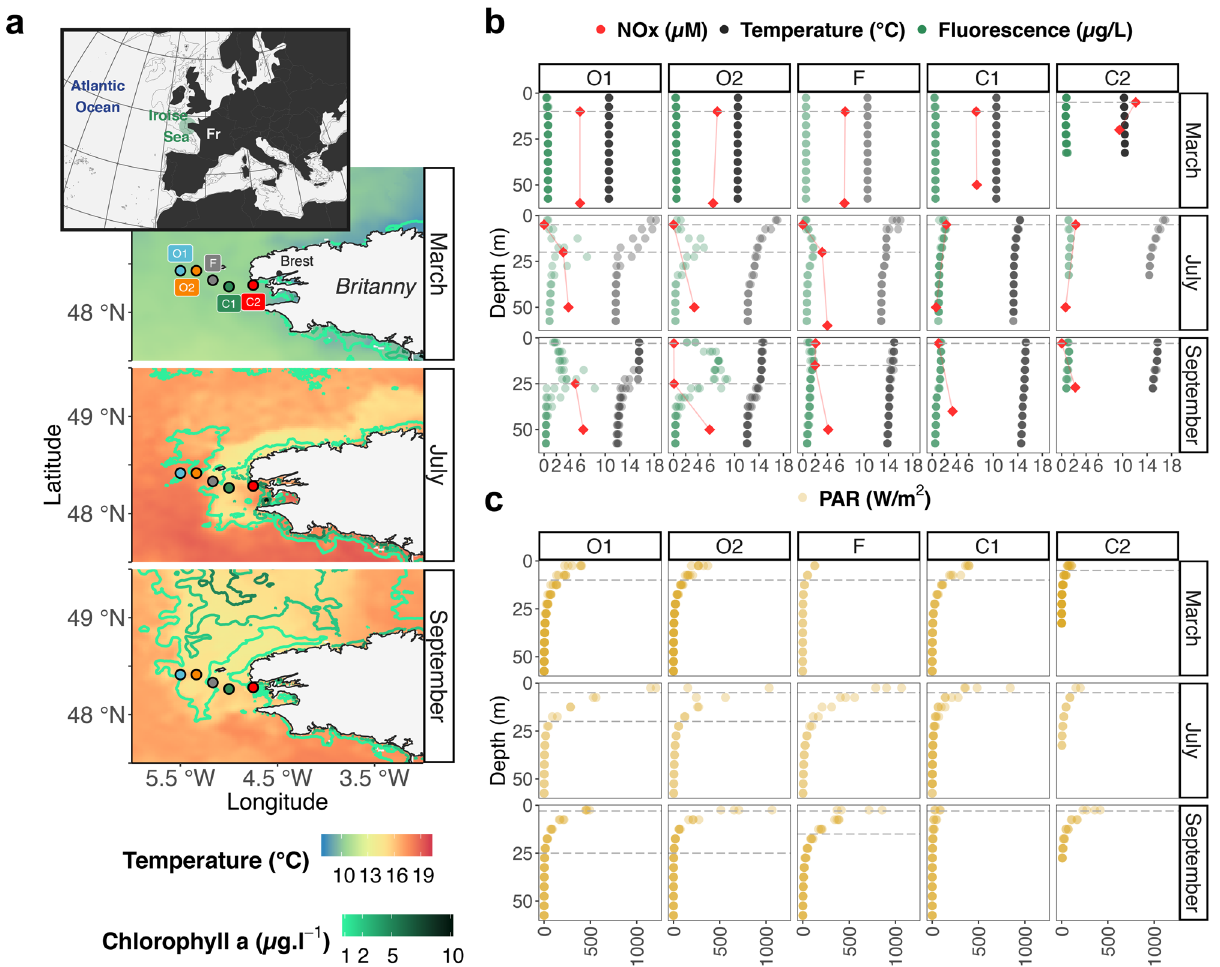
Figure 1. Map of the Iroise Sea and its hydrological conditions during our three sampling campaigns in 2015. On the map, the sampling stations (dots and names) are superimposed on the corresponding temperature (background color) and chlorophyll a (isoligns). Each map was assembled in R 50 using raster images estimated with satellite data ( source: NASA Goddard Space Flight Center, Ocean Ecology Laboratory, Ocean Biology Processing Group. Moderate-resolution Imaging Spectroradiometer (MODIS) Aqua Ocean color Data; NASA OB. DAAC, Greenbelt, MD, USA. Accessed 2017/10/17). Vertical profiles of fluorescence (green, μg/L), temperature (black, °C), and PAR (yellow, W/m 2 ) were measured on board with a CTD probe and a fluorescence sensor. Values of the down-cast were averaged every 5 m, variability comes from the triplicated casts. NOX (nitrate + nitrite, red, µM) were measured a posteriori from water sampled at three depths (a single time). Dashed horizontal lines represent the sampling depth for surface and, when present, DCM